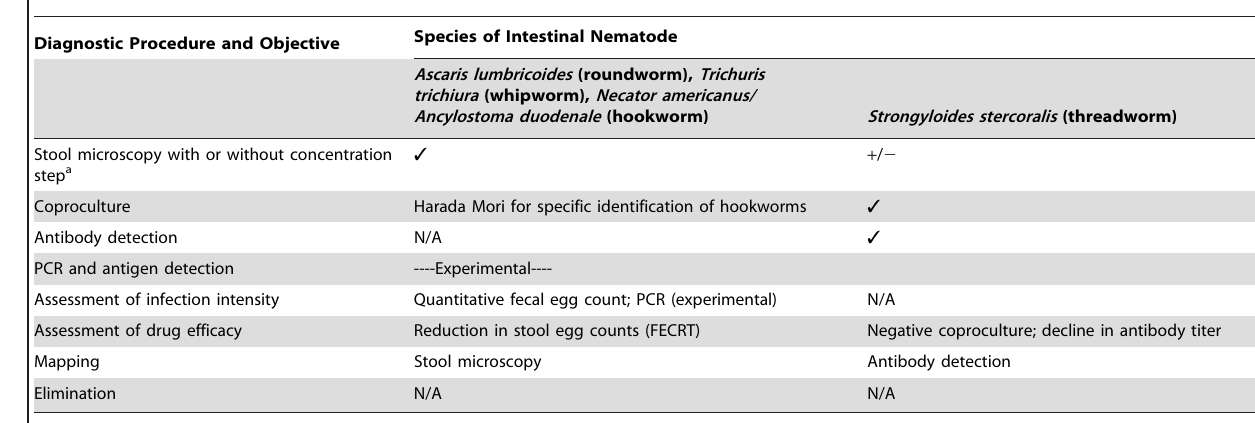
Table 2. Diagnostics Available for Soil-Transmitted Helminthiases.